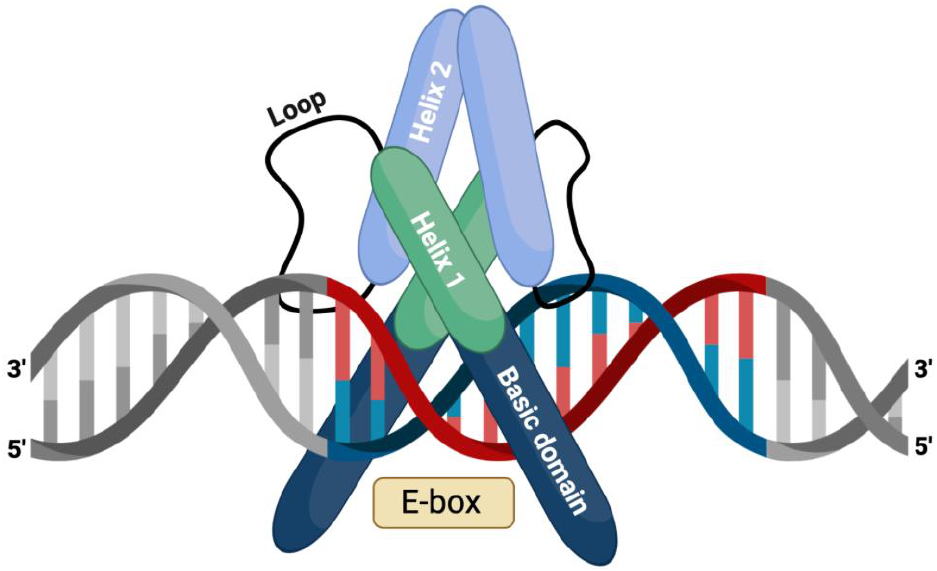
Figure 1. The structure of the bHLH transcription factor complex involved in binding to the E-box sequences of the DNA.